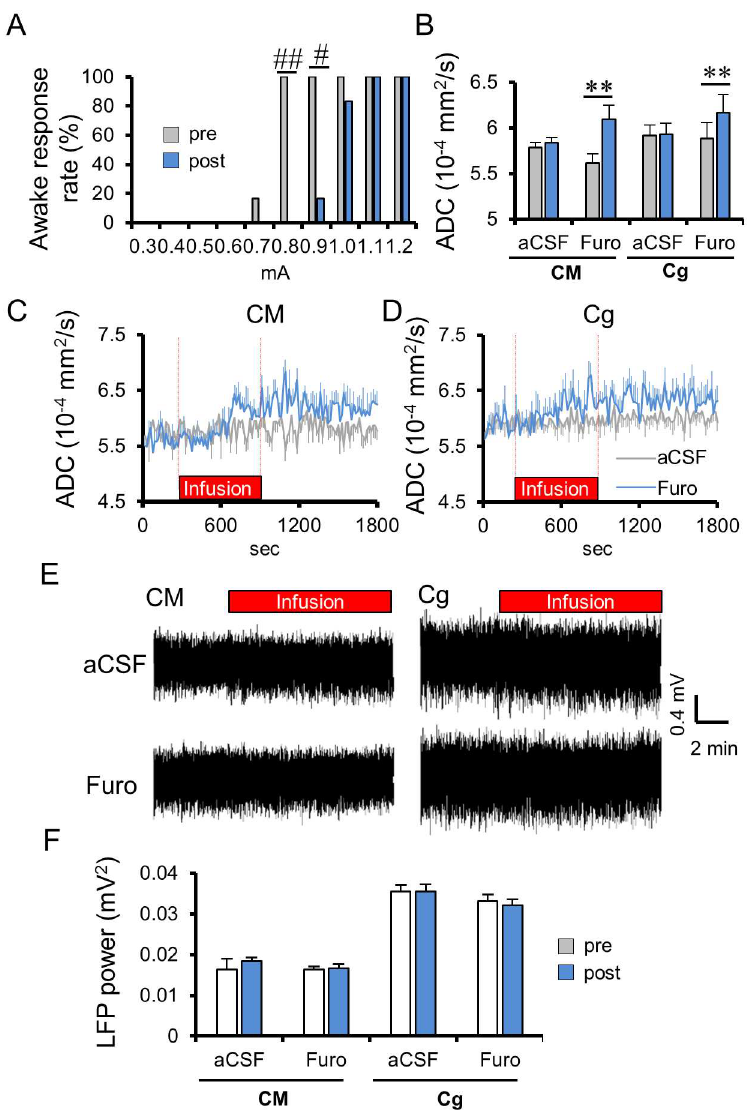
Fig 5. Effects of furosemide infusion in the Central Medial thalamus nucleus (CM) on the Apparent Diffusion Coefficient (ADC), Local Field Potentials (LFPs) and awake response threshold under 0.1 mg/kg/h medetomidine condition. (A) Percentage of animals exhibiting an awake responseduringCM electricalstimulationafter the CM infusionwith furosemide(Furo; n = 6). (B) Average ADC changein the CM and cingulatecortex (Cg) before and after CM infusion( n = 6 for artificial cerebrospinalfluid [aCSF], n = 6 for Furosemide). Average time course of ADC change in the CM (C) and Cg (D) with the infusion of aCSF and furosemide. (E) Representative local field potentials(LFP) signalsat the CM and Cg with the CM infusionwith aCSF (upper)or furosemide (below). (F) Total LFP power (frequency range: 1–70Hz) in the CM and Cg, before and after CM infusion with furosemide ( n = 6) or aCSF ( n = 6). Time course and bar plots exhibit mean ± the standarderror of the mean (SEM). ** p < 0.01 (two-sidedpaired t -test betweenpre and post), # p < 0.05 (Fisher’s exact test). Data for minimum amplitudes of individualrats can be found in S5 Data. ADC data of individualrats found in S3 Data. LFP power data can be found in S4